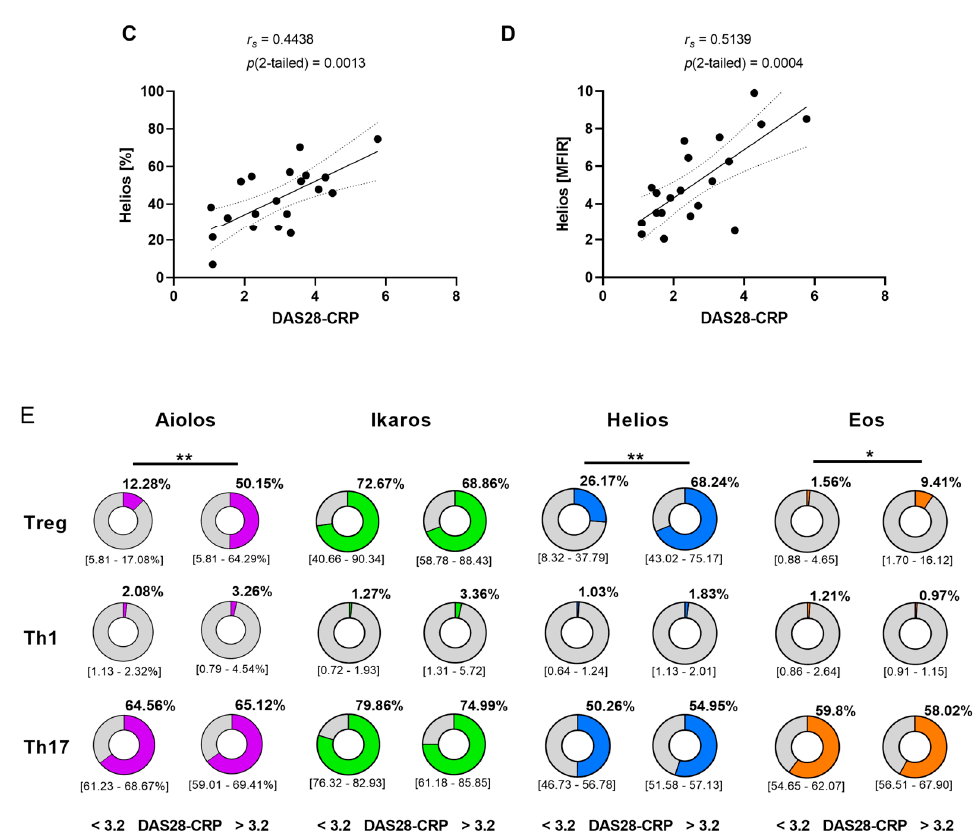
Figure 2. Correlation between disease activity and Aiolos or Helios expression in Treg cells. ( A ) Correlation between Aiolos expression (%) in Treg cells and DAS28-CRP in patients with RA ( n = 20). ( B ) Correlation between mean fluorescence intensity ratio (MFIR) of Aiolos in Treg cells with DAS28-CRP in patients with RA ( n = 20). ( C ) Correlation between Helios expression (%) in Treg cells and DAS28-CRP in patients with RA ( n = 20). ( D ) Correlation between mean fluorescence intensity ratio (MFIR) of Helios in Treg cells with DAS28-CRP in patients with RA ( n = 20). ( E ) Percentage of Aiolos, Ikaros, Helios or Eos expressing Treg cells, Th1 cells and Th17 cells in the peripheral blood of patients with low disease activity (DAS28-CRP ≤ 3.2) or high disease activity (DAS28-CRP > 3.2) ( n = 20). Significance was calculated by Spearman’s Rho test or by one-way ANOVA with Tukey’s multiple comparison test. Where indicated, results are presented as the median with interquartile ranges (IQR) (* p < 0.05, ** p <